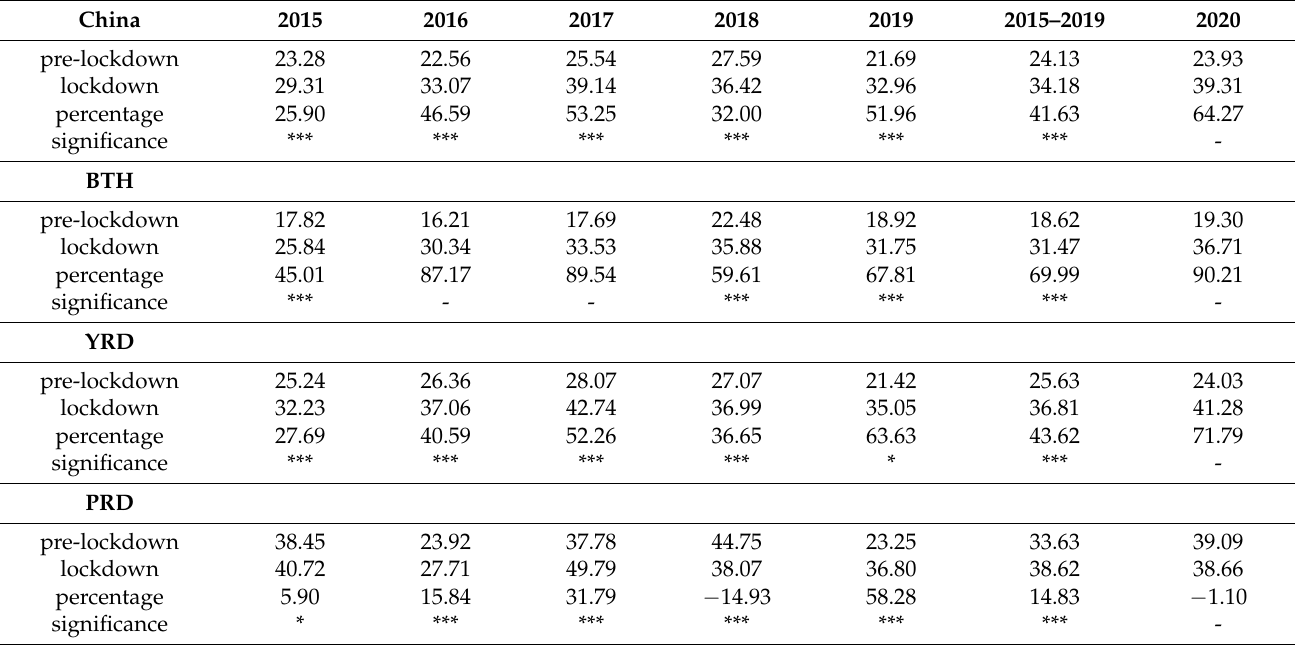
Table 1. Mean O 3 concentrations (ppbv) during pre-lockdown and lockdown periods and the percentage changes